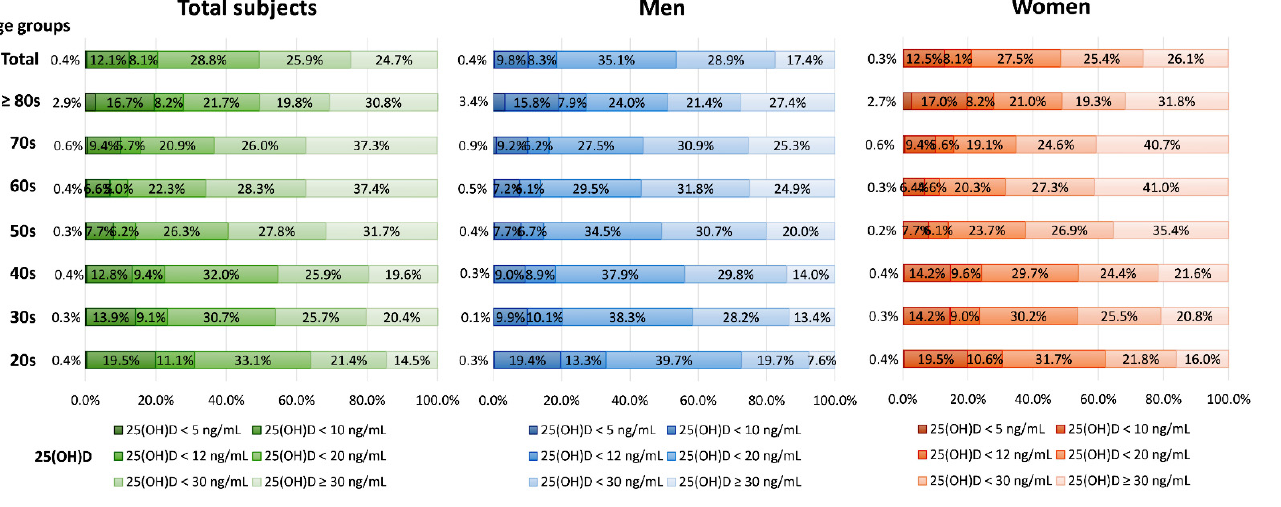
Figure 1. Prevalence of vitamin D deficiency status based on serum 25(OH)D level by sex and age. Because Korea is located at mid-latitude in the Northern Hemisphere, June to August is the summer season. The prevalence of subjects with 25(OH)D deficiency and median 25(OH)D level fluctuated by month (i.e., higher levels during summer and lower levels during winter). The median 25(OH)D level and the prevalence of each vitamin D status are presented in Figures 2 and 3. The patterns of fluctuation of median 25(OH)D levels by month (changes by season) were similar between men and women. The median 25(OH)D levels slightly increased from 2017 to 2021.